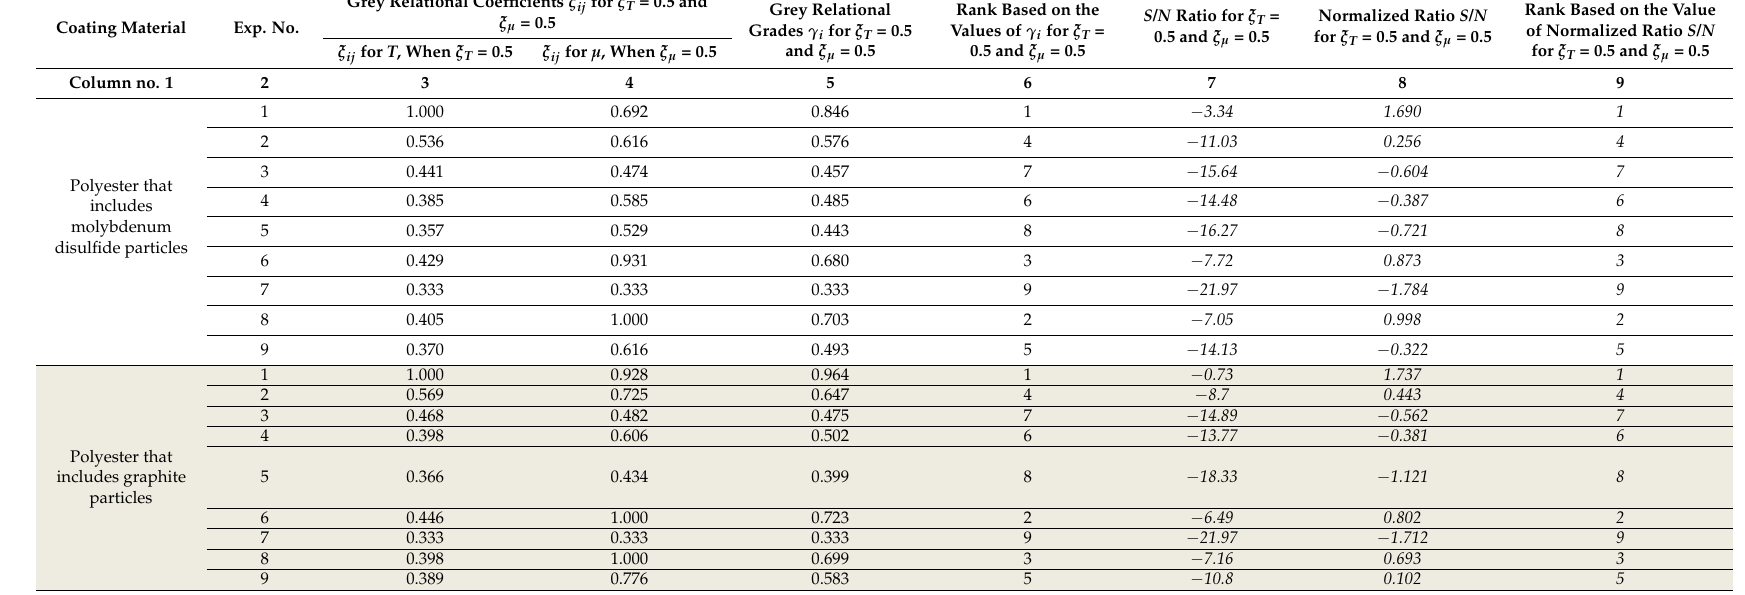
Table 2. Results of mathematical processing of the experimental data when ξ T = 0.5 and ξ µ =